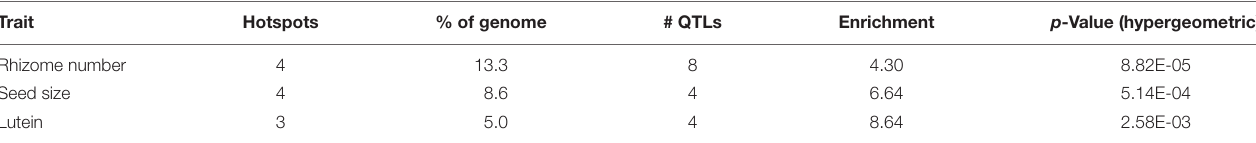
TABLE 3 | Sorghum QTLs associated with chromosomal ‘hotspots’ for introgression of sorghum alleles into five geographically diverse S. halepense populations (Morrell et al.,